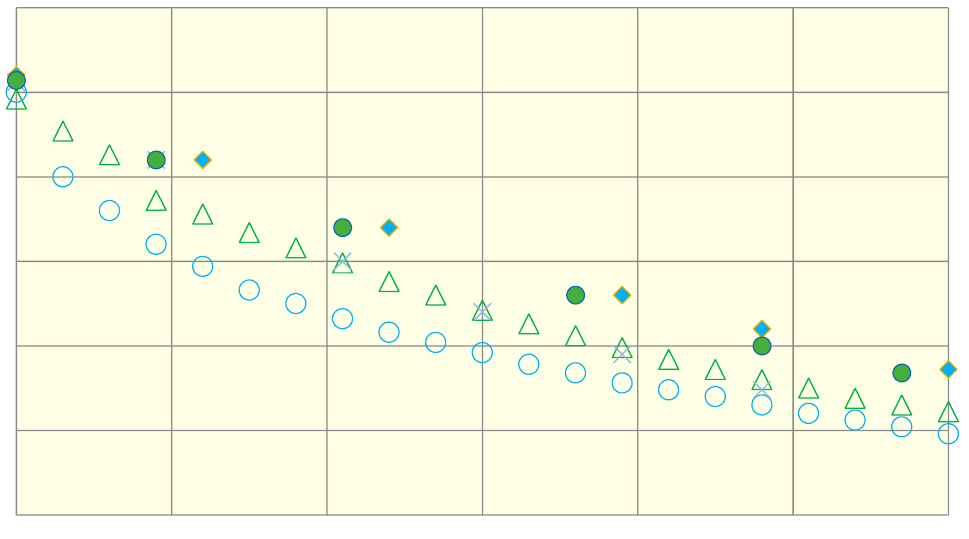
—1 (dose 0 kGy); (cid:7) —2 (cid:35)